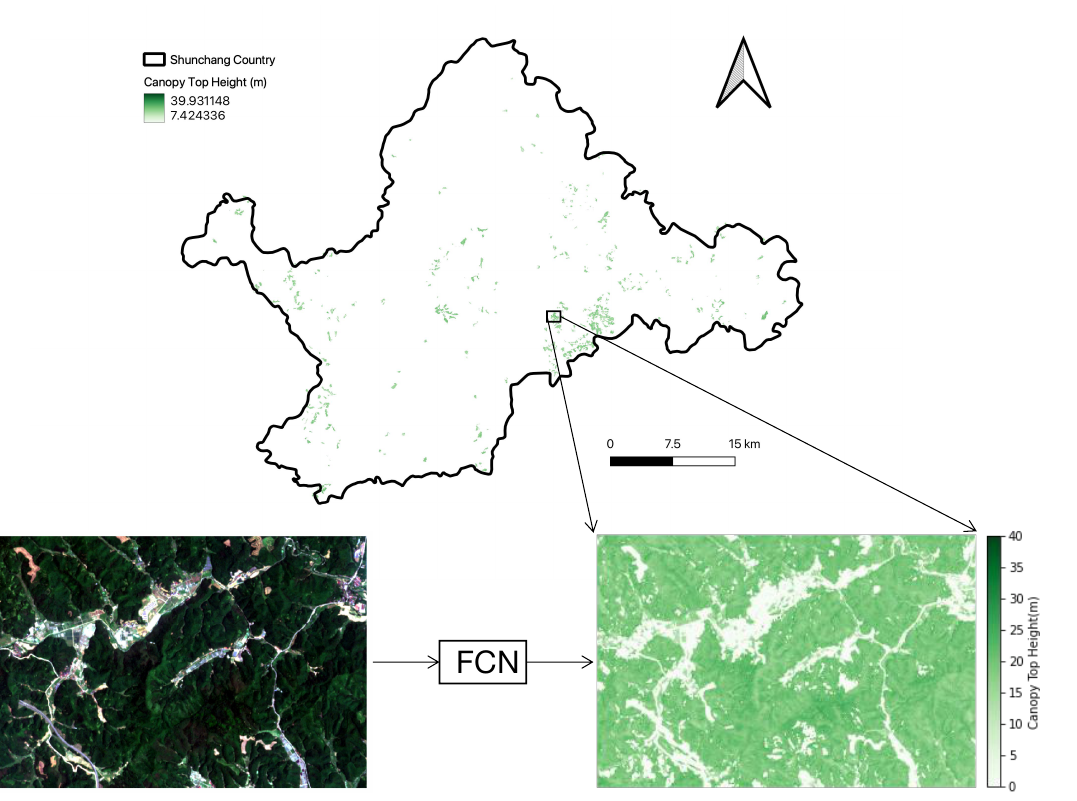
Figure 7. Project-level dense canopy top height mapping.